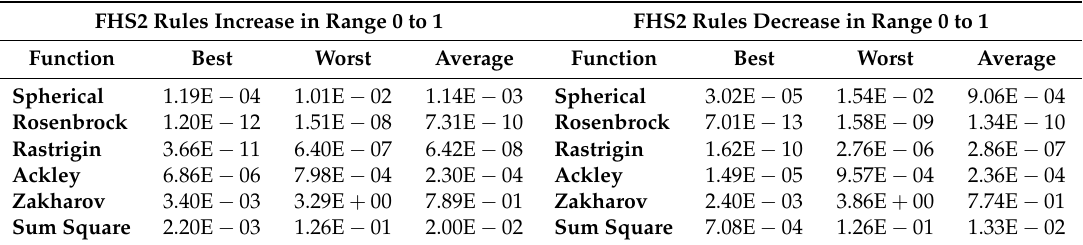
Table 6. Results obtained with FHS2 using fuzzy logic to increase and decrease PArate with 0 to 1 range applied to six benchmark mathematical functions.